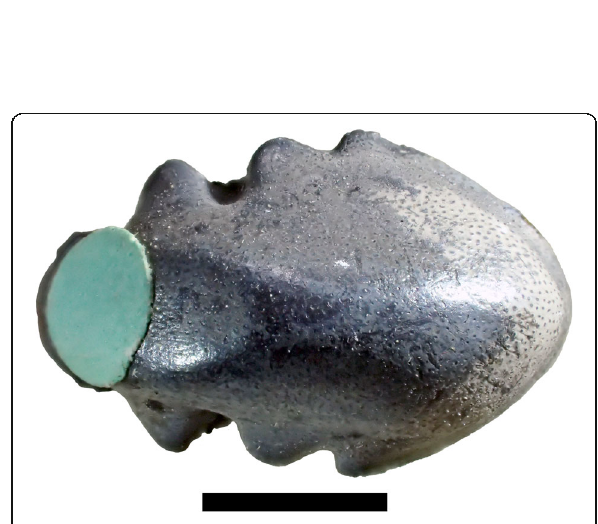
Fig. 3 Occlusal view of tooth plate of Pleuroplax rankinei (Hancock and Atthey, 1872) [20] . One of eight tooth plates labeled NHMUK PV P1415. Lingual end to right. Scale bar = 5 mm